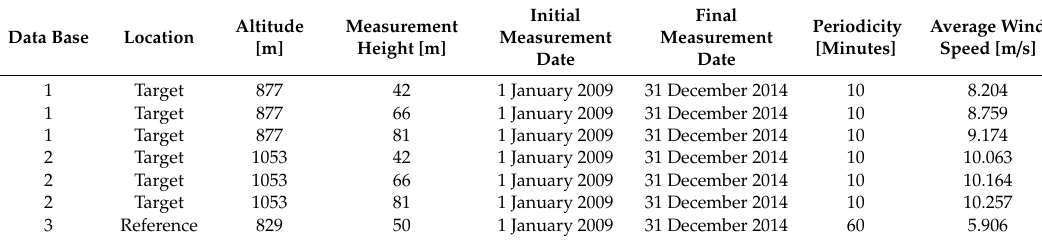
Table 1. Characterization of the databases of